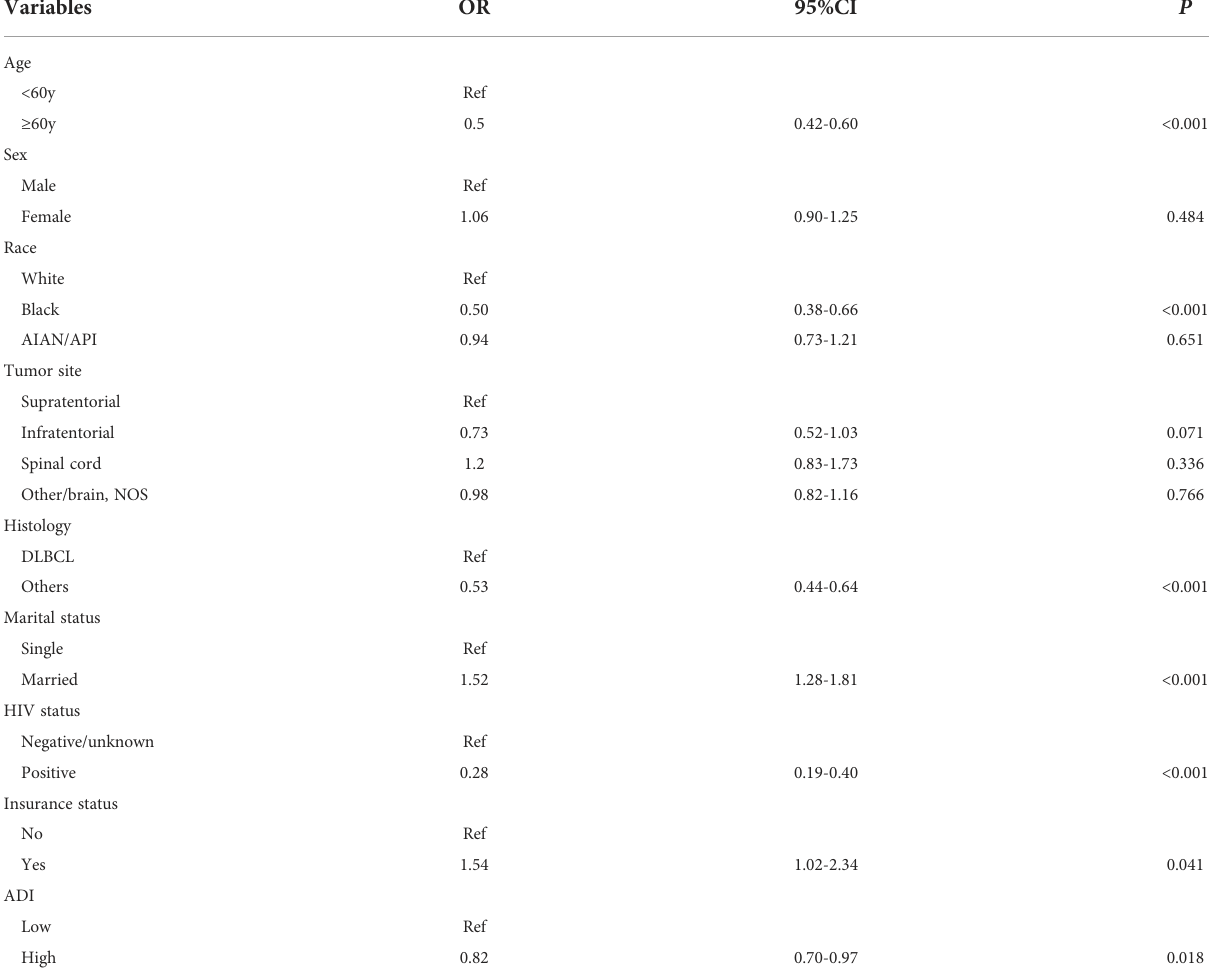
TABLE 2 Multivariable logistic regression to predict odds of receiving chemotherapy for PCNSL patients.